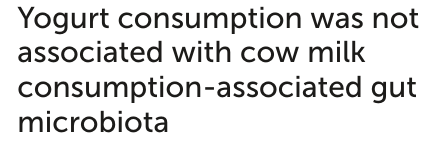
s__Prevotella_copri_CAG_164, P CLR = 0.057 ) of these